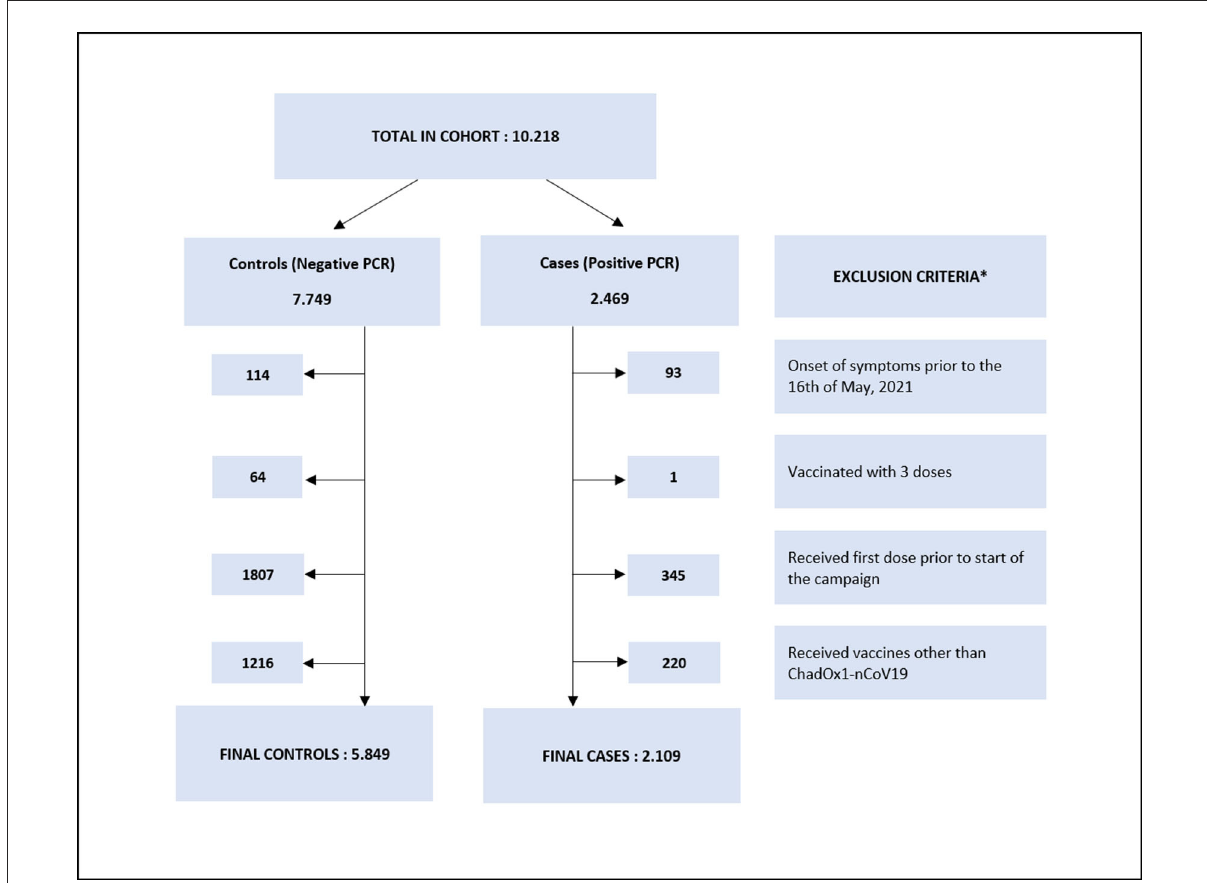
FIGURE1 Exclusion criteria applied to overall cohort. *Exclusion criteria may